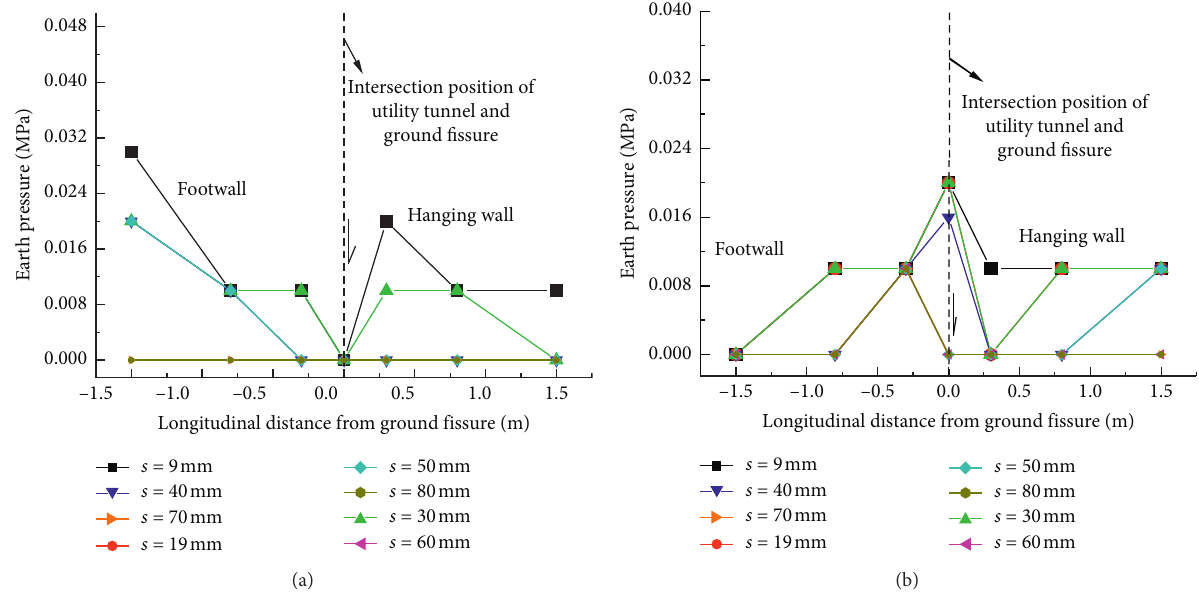
Figure 13: Lateral earth pressure change curve on the north and south. (a) Lateral earth pressure change curve on the north. (b) Lateral earth pressure change curve on the south.